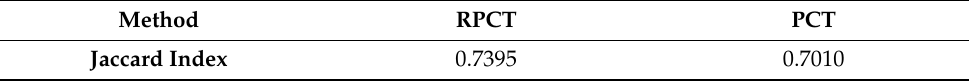
Table 4. Jaccard Index values of RPCT and PCT